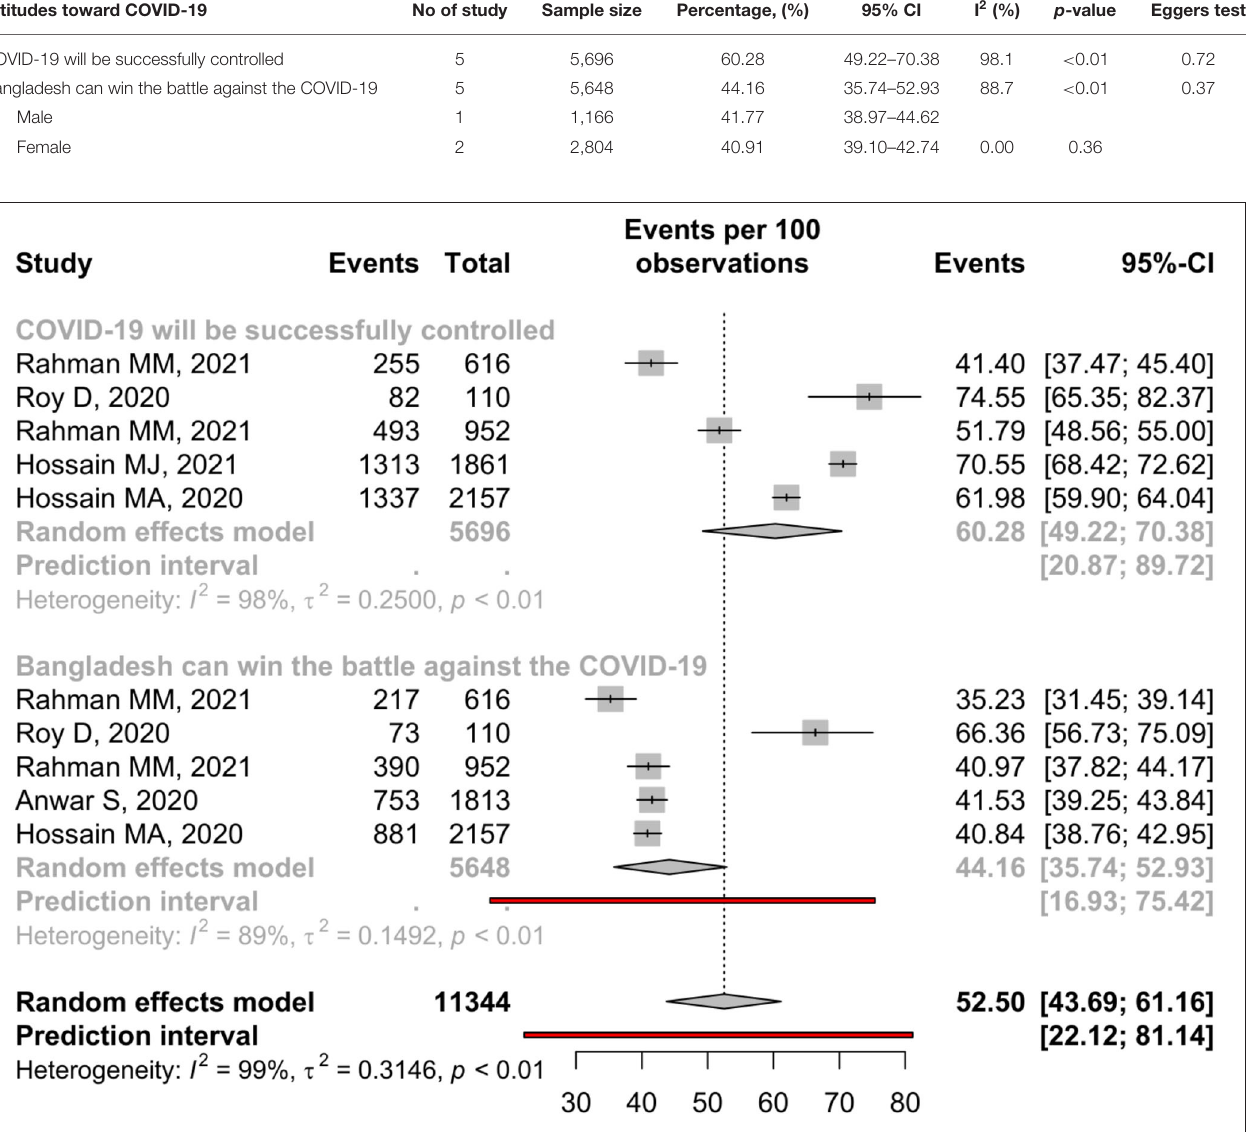
were aware of the fact that COVID-19 can transmit through respiratory droplets. A substantial amount of study heterogeneity was identified (I 2 = 99.1%), where Eggers tests showed a small-study effect ( Table 2 ). The forest is presented in In the subgroup analysis of gender, it was found that males (85.67%, 95% CI: 65.11–95.04%) and females (85.69%, 95% CI: 61.45–95.74%) had the almost same level of knowledge of COVID-19 transmission. Appropriate knowledge of transmission was estimated as 85.82 % (95%, CI: 66.41– 94.88%) in CBCS and 95.82% (95%, CI: 92.50–97.70%) in IBCS ( Supplementary Material